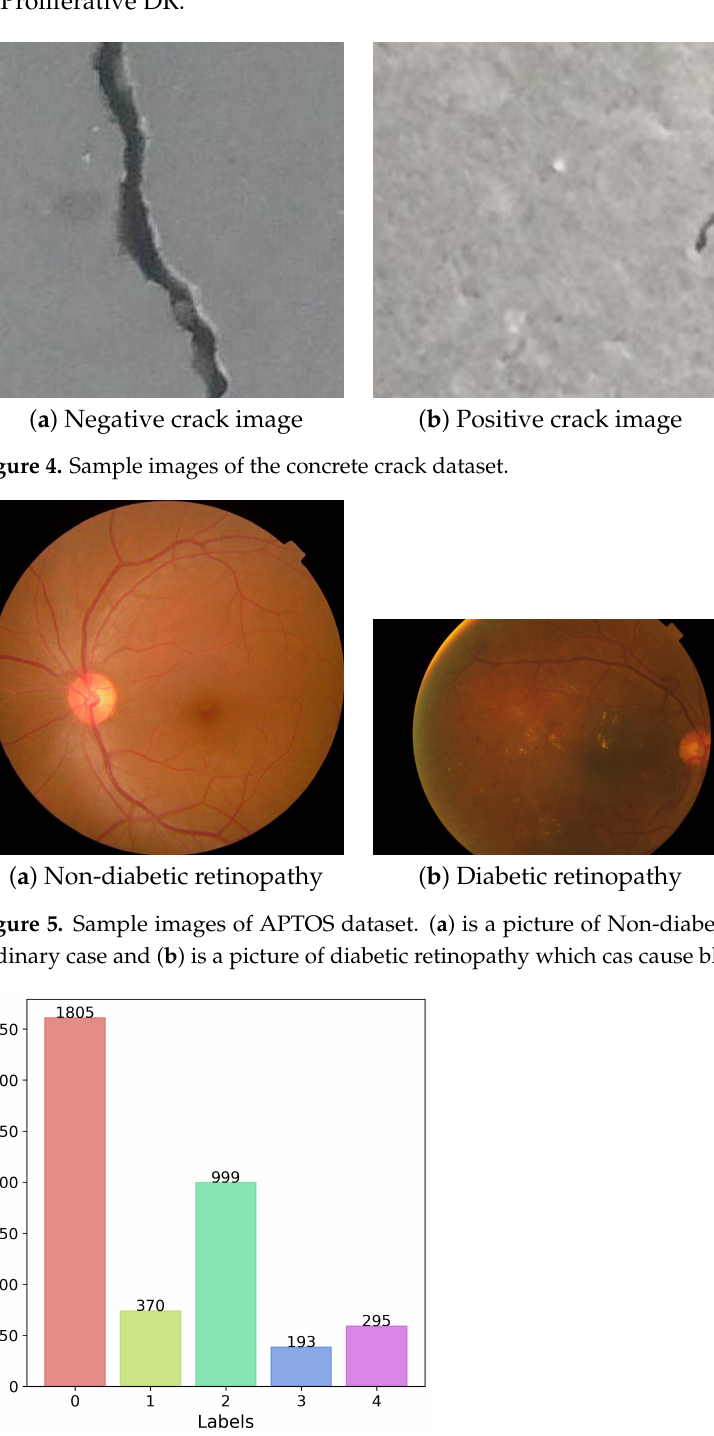
Figure 6. Data distribution for APTOS 2019 blindness detection dataset. This dataset can be classified as non-diabetic and diabetic. Around 50% of images are categorized as non-diabetic retinopathy (label 0) and diabetic retinopathy is subdivided according to the severity range from 1 to